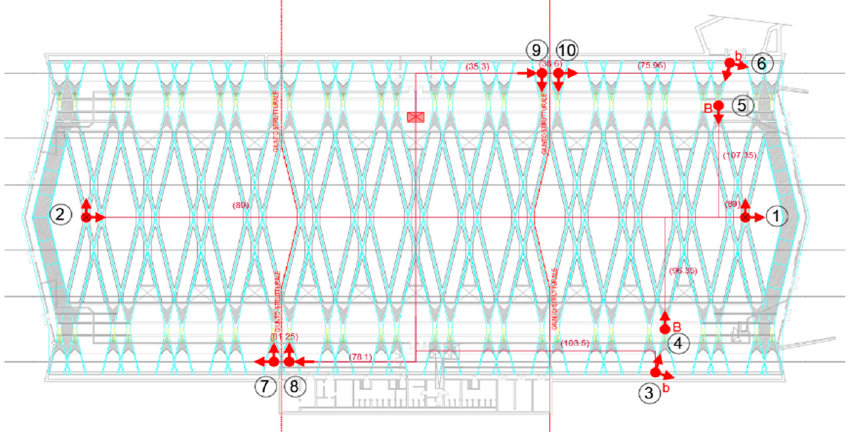
Figure 10. Sensors on the x-y plane in Setup 1. The numbers 1-10 in figure refer to identifiers of different sensors position.